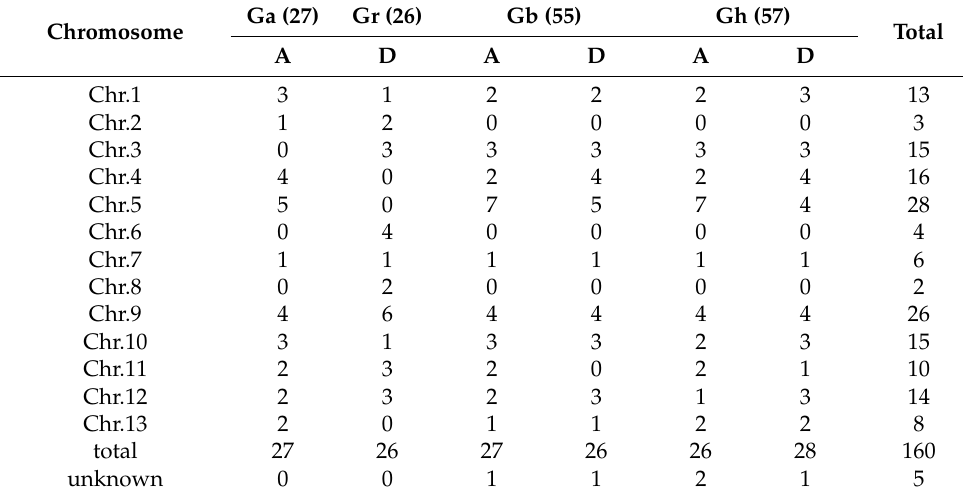
Table 2. Number of EXO70s in each chromosome of different cotton species.